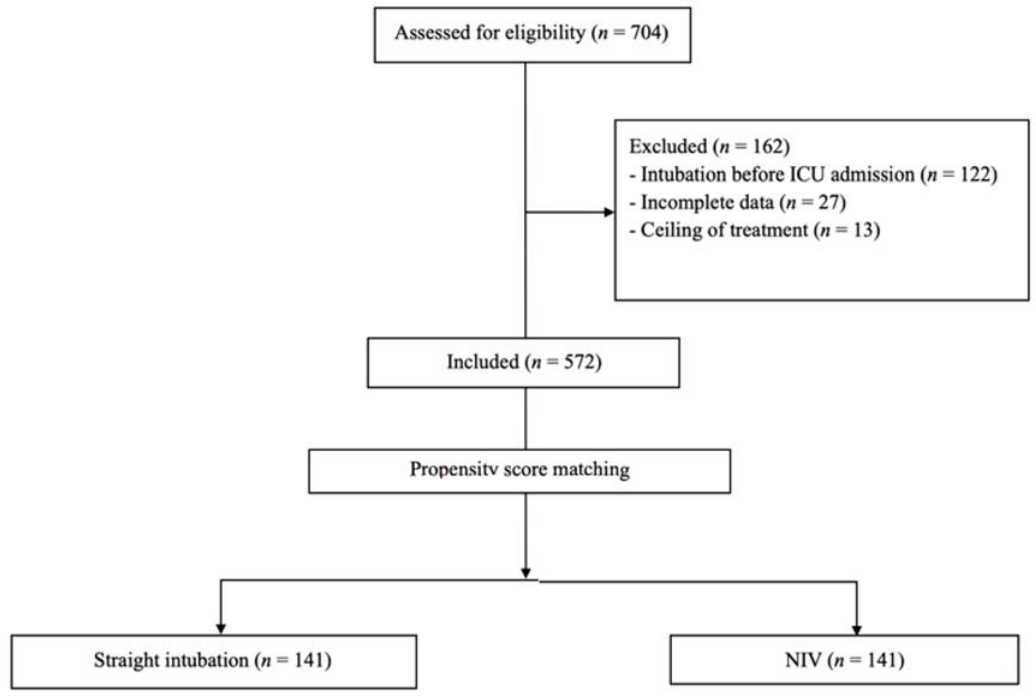
Figure 1. Flow diagram of screened and enrolled